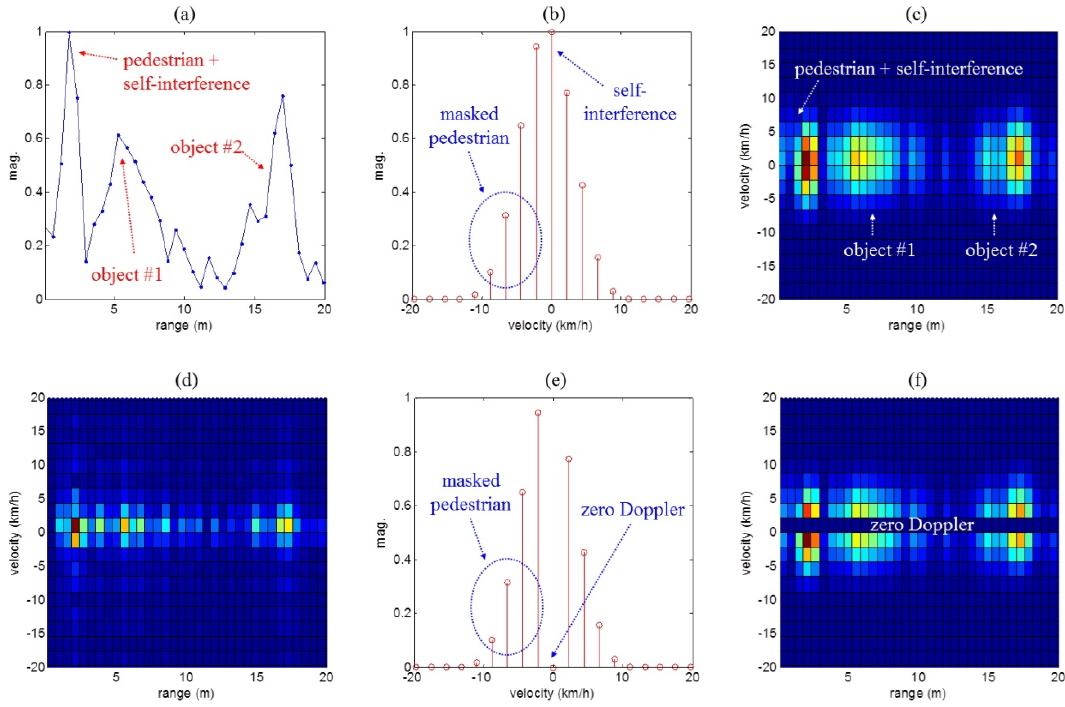
Figure 9. Cont Figure 9. Cont. Figure 9. Cont.